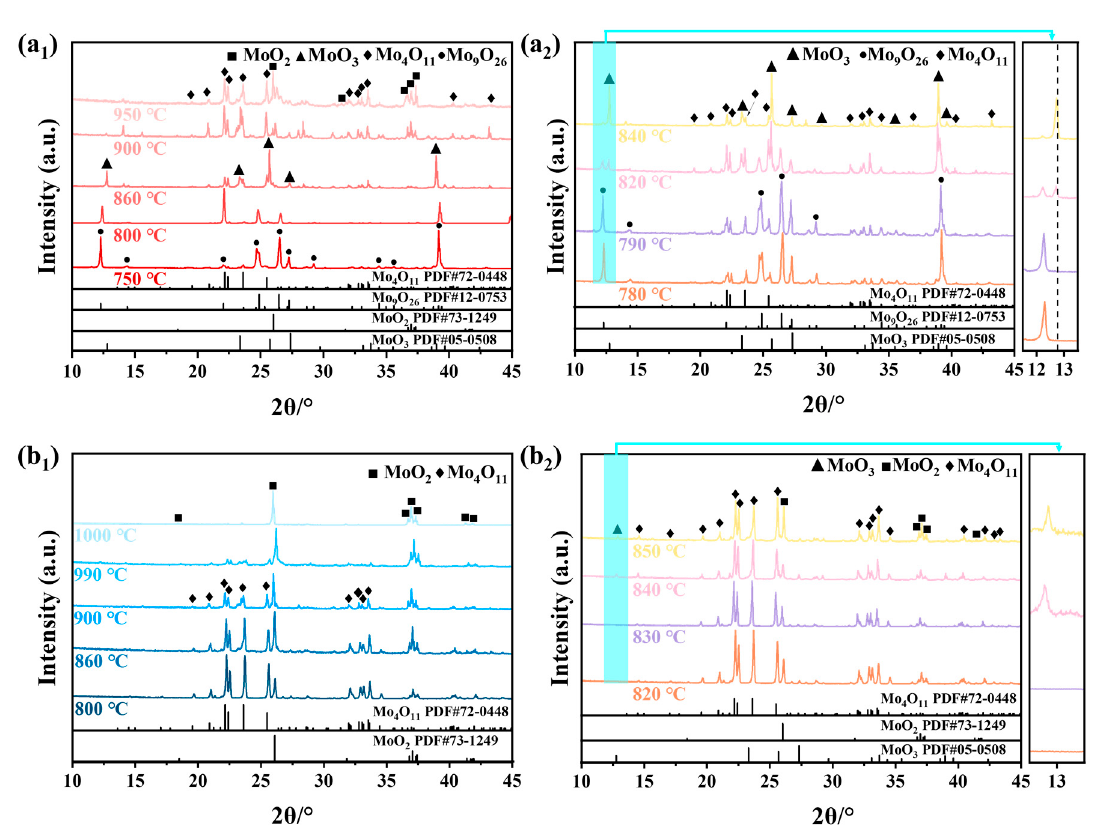
Figure 4. XRD patterns of the Mo 9 O 26 ( a 1 , a 2 ) and Mo 4 O 11 ( b 1 , b 2 ) powders after heat treatment. Table 1. Phase compositions of the Mo 9 O 26 powders after heat treatment.